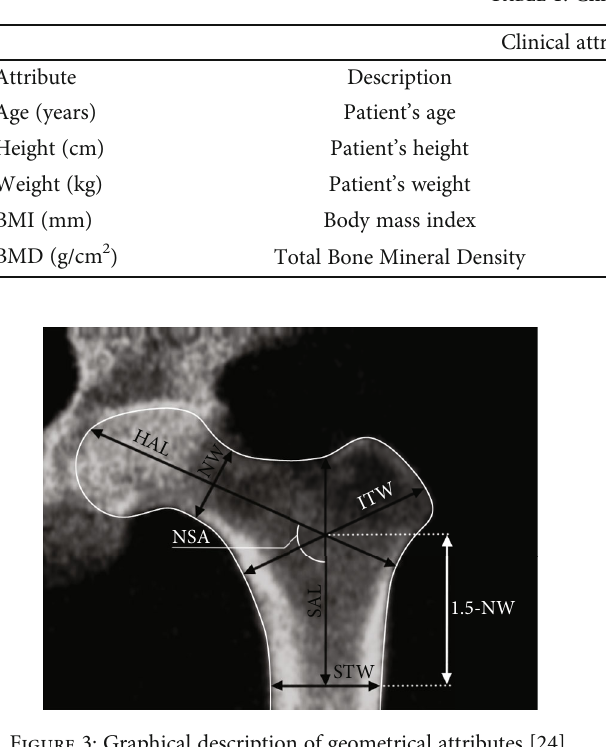
Table 1: Clinical attributes.